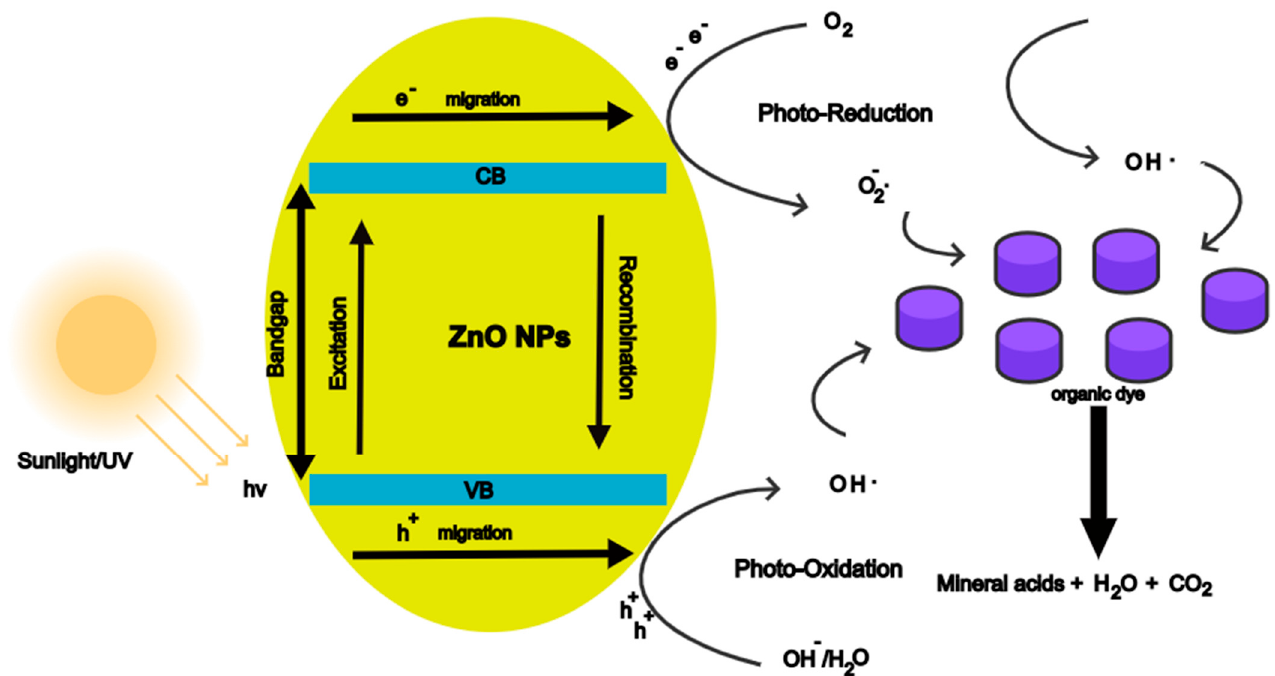
Figure 7. Mechanism of photodegradation of organic dye.